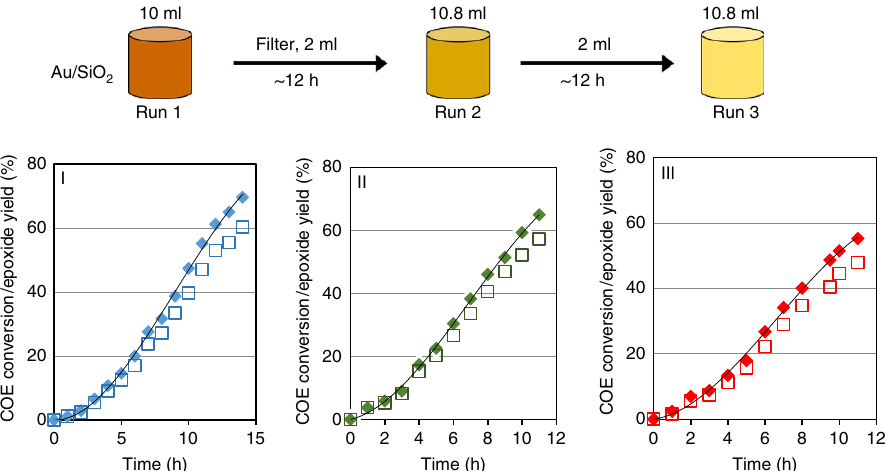
Figure 3 | Cyclooctene conversions in consecutive experiments. Experiments of repeated use of filtrate from a COE epoxidation run using Au/SiO 2 -A as Au source. Run 1 (panel I) was a reaction similar to those in Fig. 1. Afterwards, the mixture was hot-filtered. 2ml of filtrate from Run 1 was used for Run 2 by adding COE and an internal standard of decane to 10.8ml total volume (panel II), and 2ml of the reaction mixture of Run 2 was mixed with fresh COE/decane for Run 3 (panel